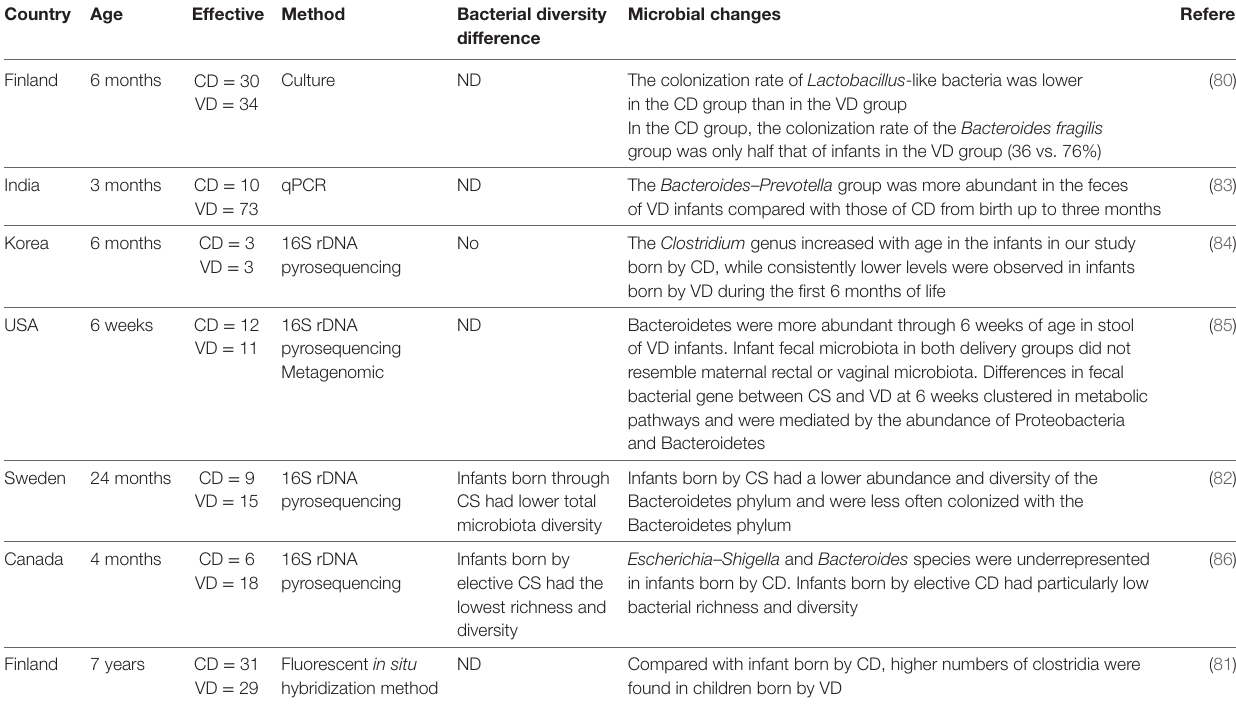
TAbLe 2 | Long-term alteration of the gut microbiota associated with cesarean section. Country